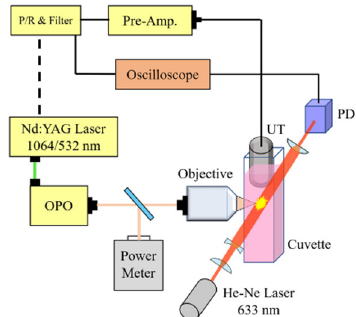
Figure 2. Configuration of a pulsed laser for inducing nanobubbles and microbubbles in a quartz cuvette containing GNR colloid and optical/photoacoustic measurement system. A pulsed laser of Nd:YAG with an OPO output a pulsed light with tunable wavelength (6750–1000 nm). A probing laser system (He-Ne laser and PD) for the measurement of the light-scattering signal and UT with an amplifier for the photoacoustic signal of the dynamic formation of nanobubbles and microbubbles. Three orthogonal axes (pulsed laser beam, probing laser beam, and UT) intersect at the focal point of the pulsed laser and UT.